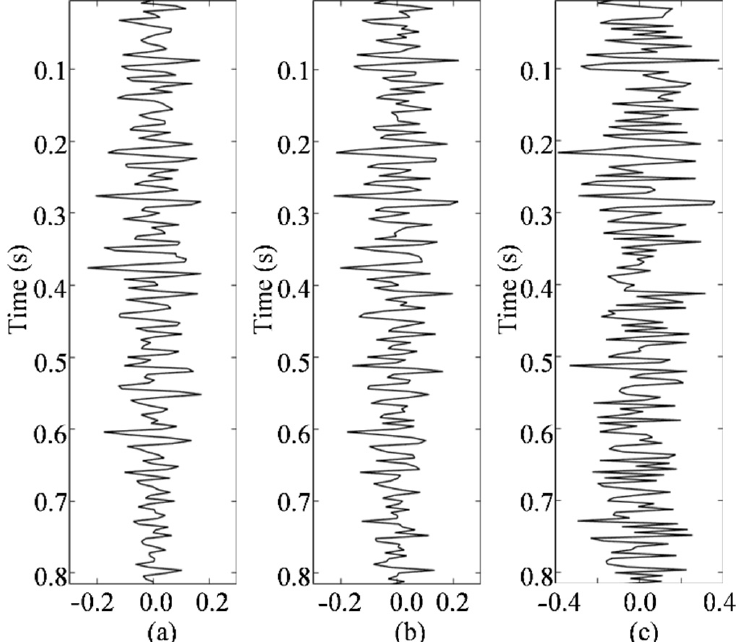
Figure 2. The synthetic seismic trace from the convolution between a 40Hz Ricker wavelet and the reflectivity series shown in Figure 1a. ( a ) Noise-free synthetic trace; ( b ) noise-contaminated trace with SNR = 4 (SNR means the ratio of signal to noise); ( c ) noise-contaminated trace with SNR = 1.